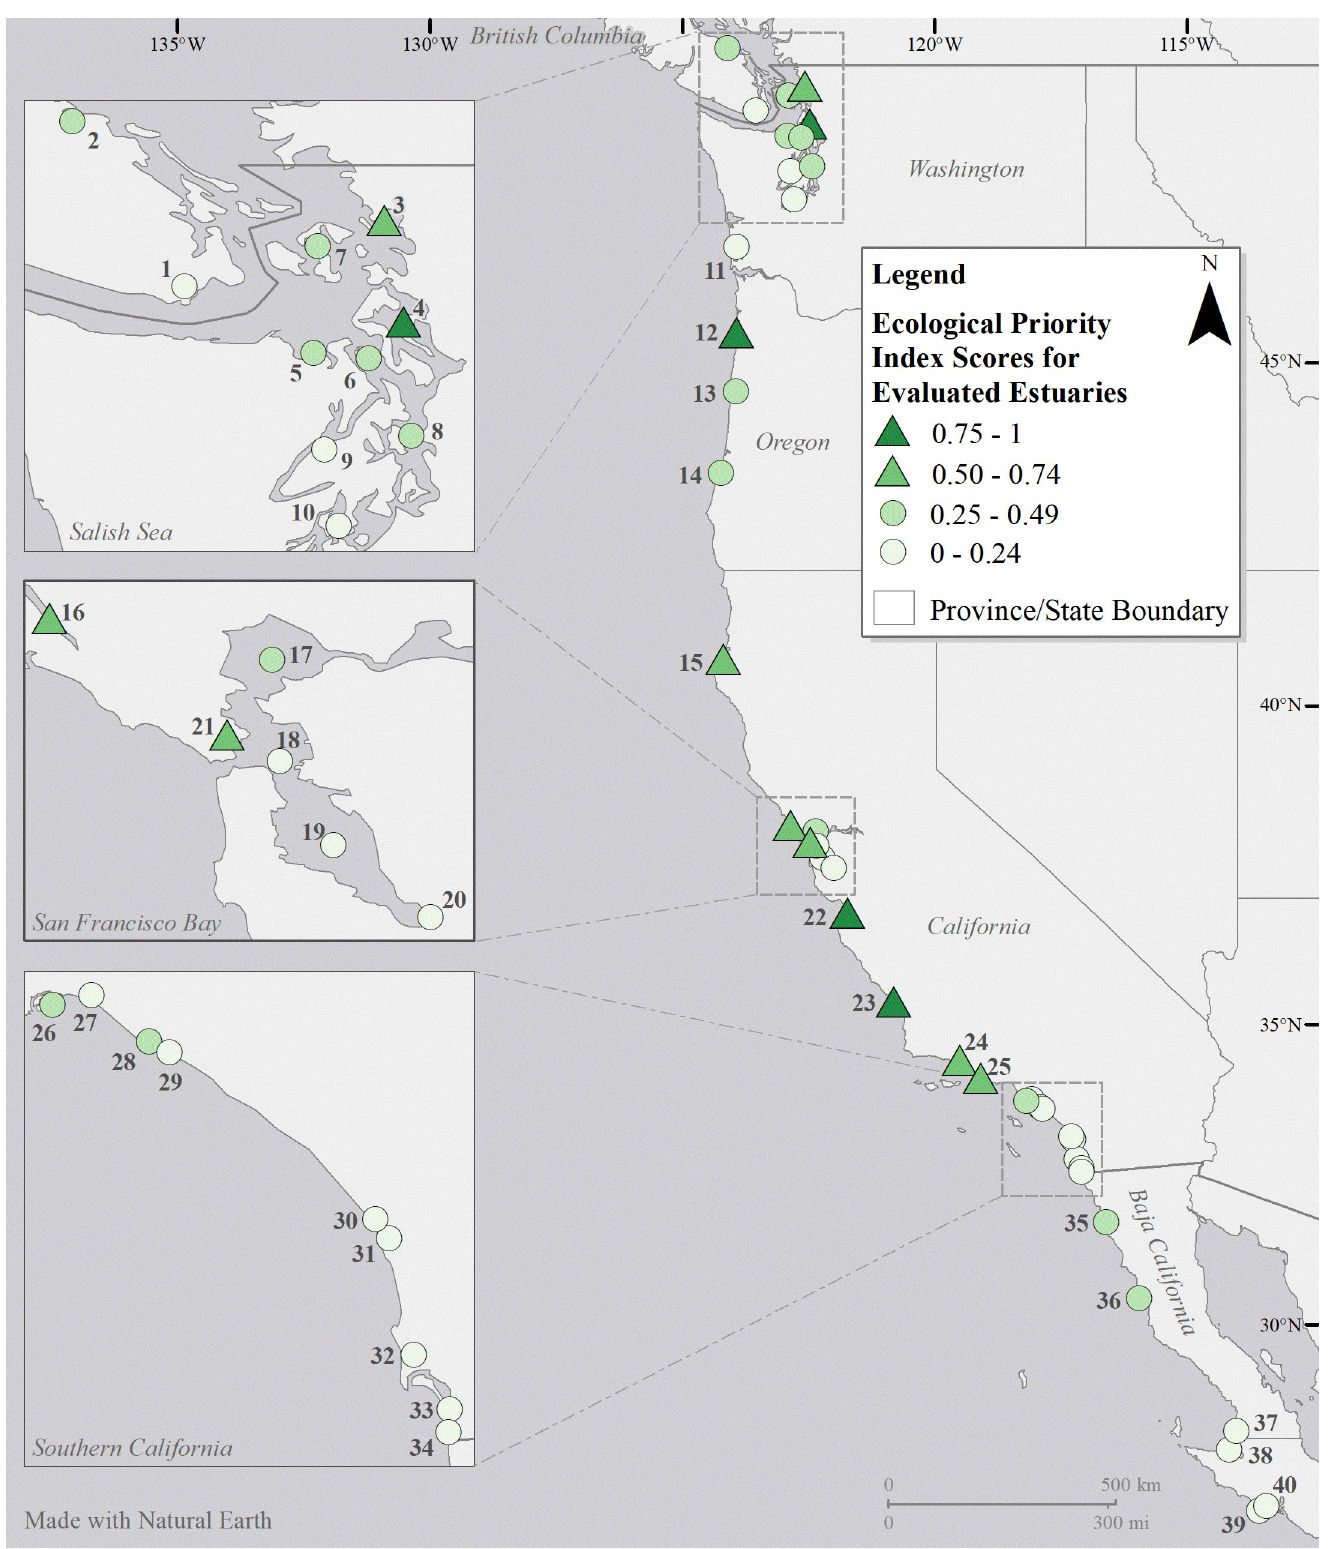
Fig 1. Location of estuaries and their ecological priority index scores. Names of the numbered estuaries are provided in Fig 2.